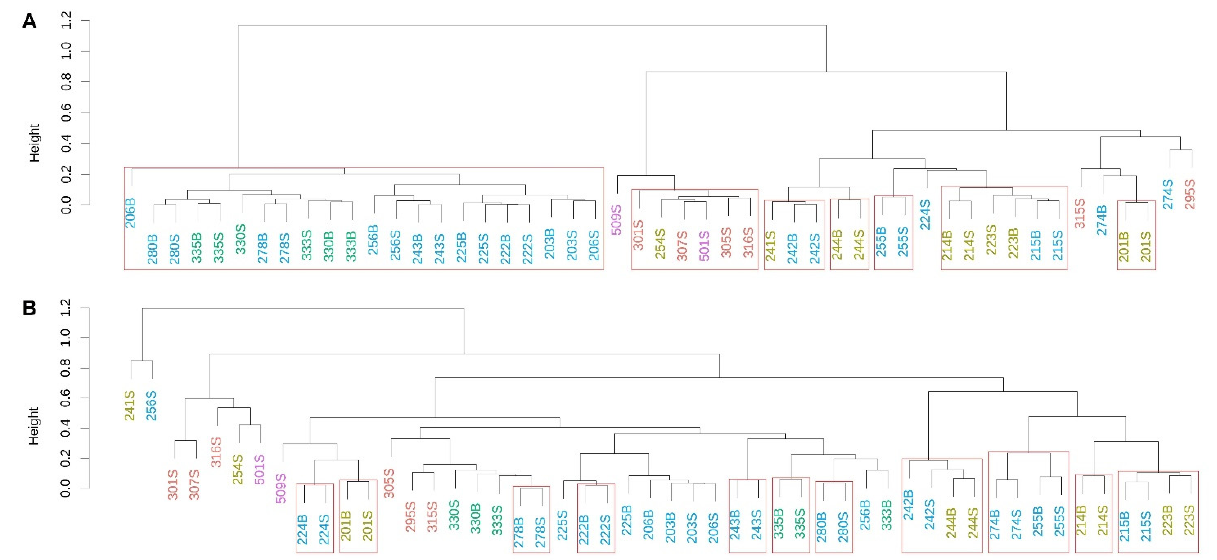
Figure 4. Cluster dendrograms (unweighted pair group method with arithmetic mean, UPGMA) based on weighted UniFrac distance matrices for prokaryotic ( A ) and eukaryotic ( B ) communities. Significant clusters (approximately unbiased p -values, AU, ≥ 95%, 1000 iterations) are indicated with by red boxes. The color code for the stations follows Figure 1.